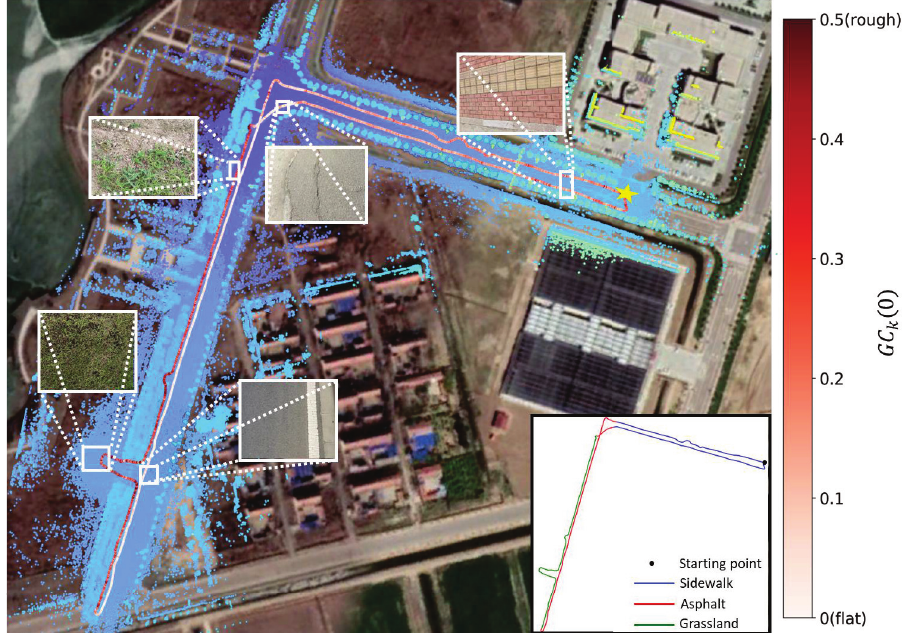
Figure 6. Trajectories and Point cloud map aligned with Google Earth satellite map of the park dataset. The dataset starts and ends at the same position which is indicated by the yellow star in the figure. The enlarged drawing is the real picture of the related ground condition. The detailed distributions of different types of ground conditions can be seen on the lower right corner.